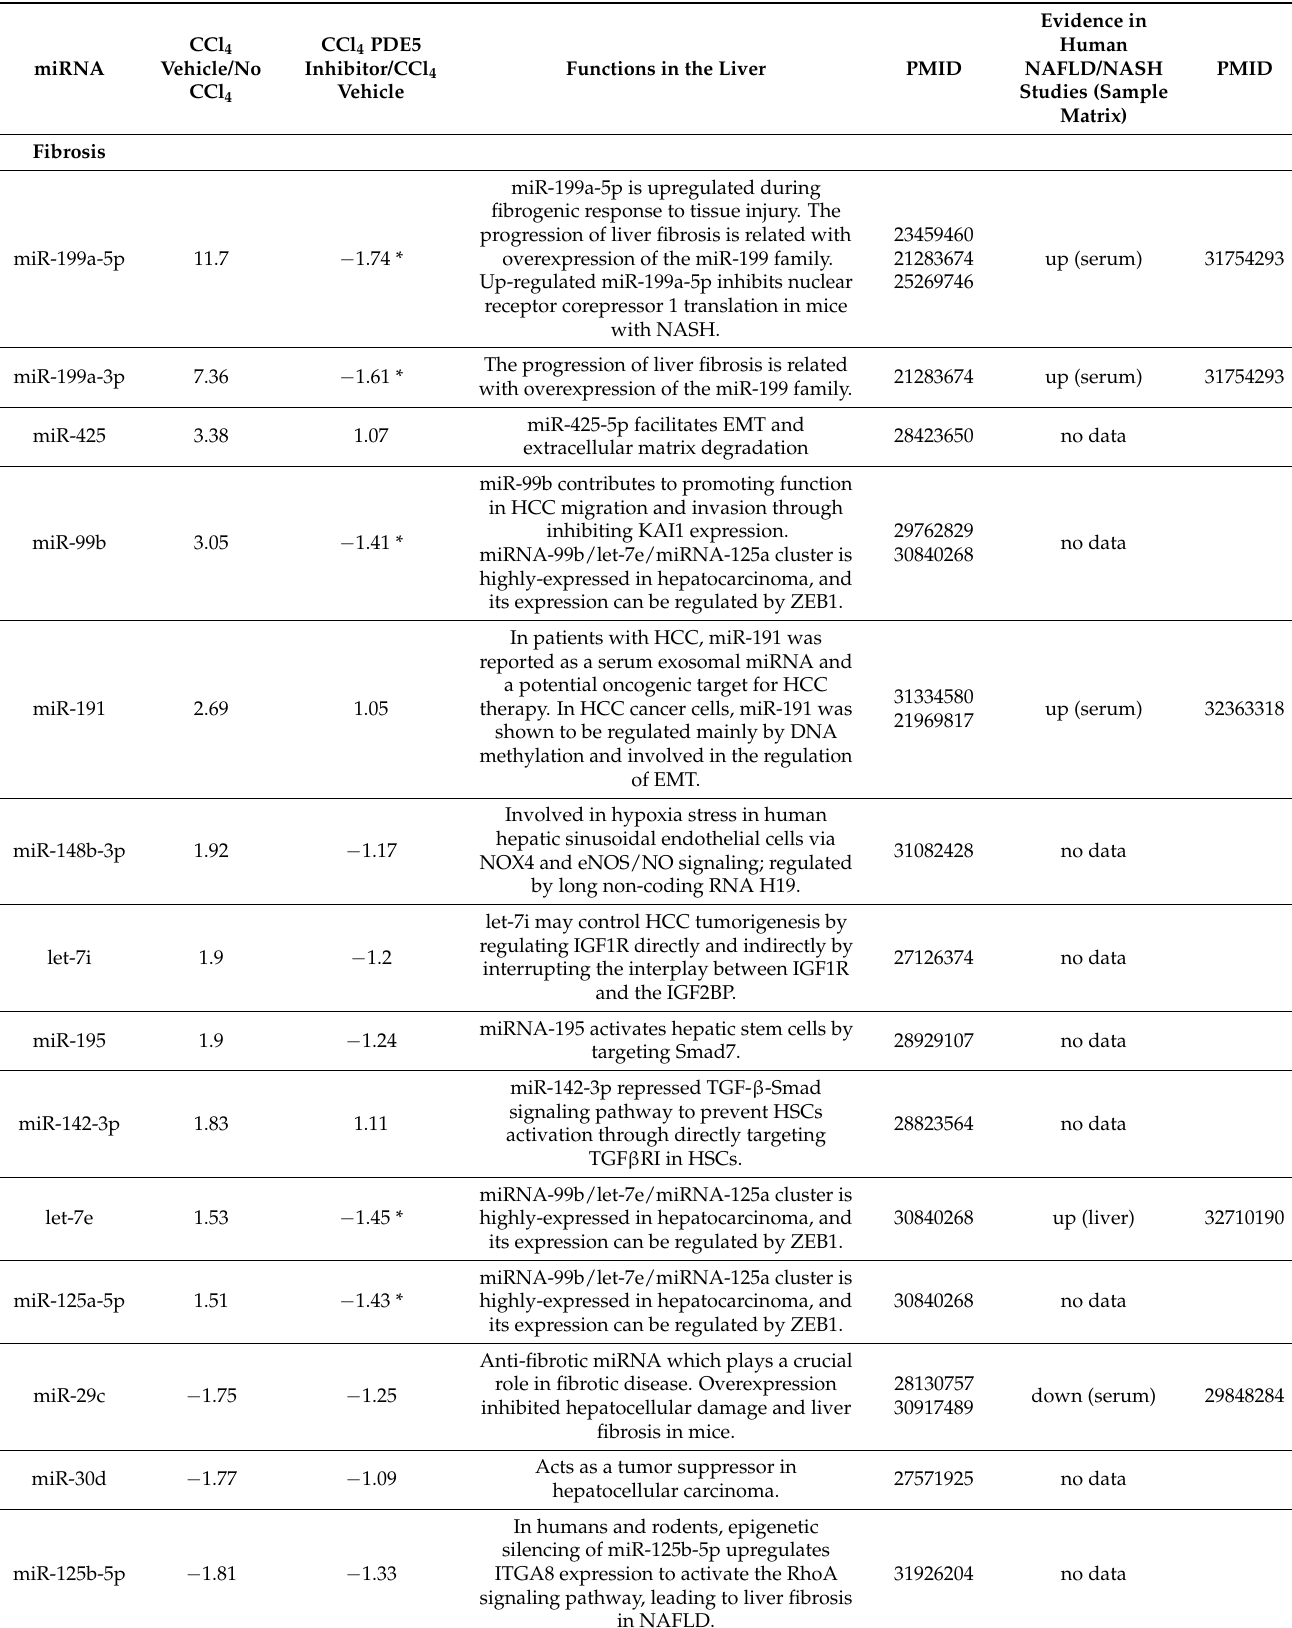
Table 2. Effects of PDE5 inhibitor on differentially expressed miRNA in liver from CCl 4 treated rats.